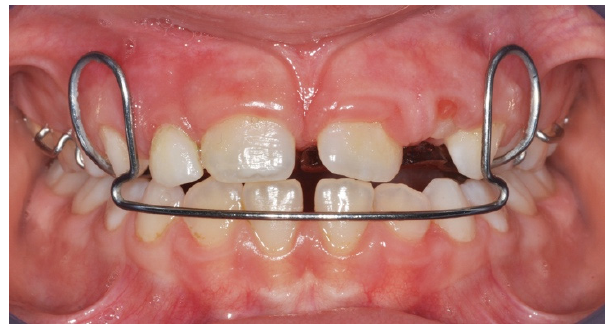
Figure 3. Removable Mandibular Retractor.